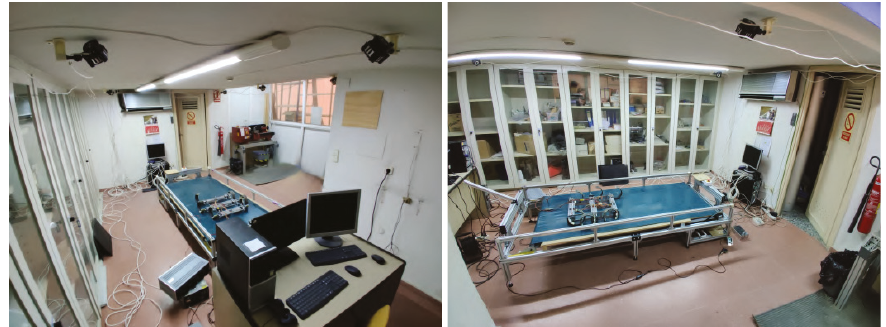
Figure 13. Test room for the odometry tests.